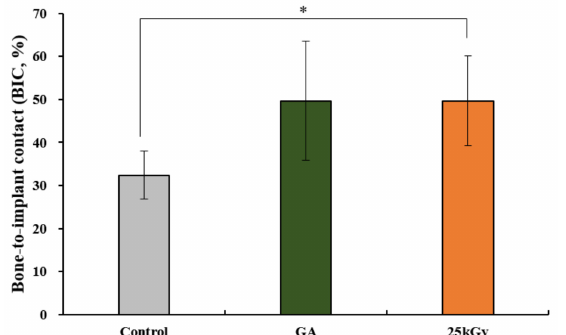
Figure 8. Bone-to-implant contact (BIC) of each group at 4 weeks after surgery (%). The symbol “*” indicates statistical significance between the two groups (* p <